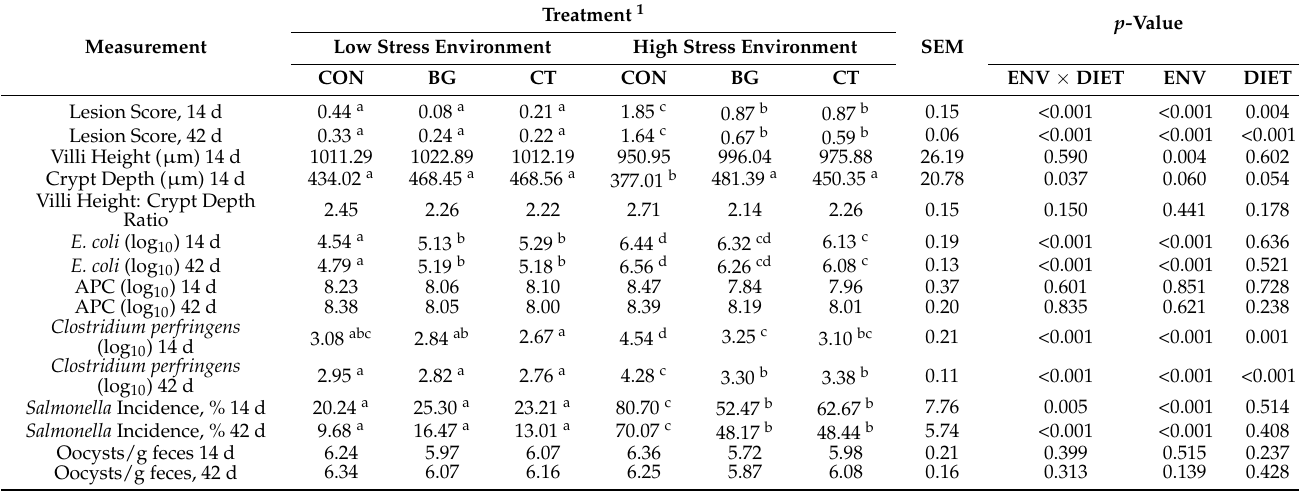
Table 4. Intestinal measurements of birds fed betaGRO and celluTEIN under different environmental conditions.